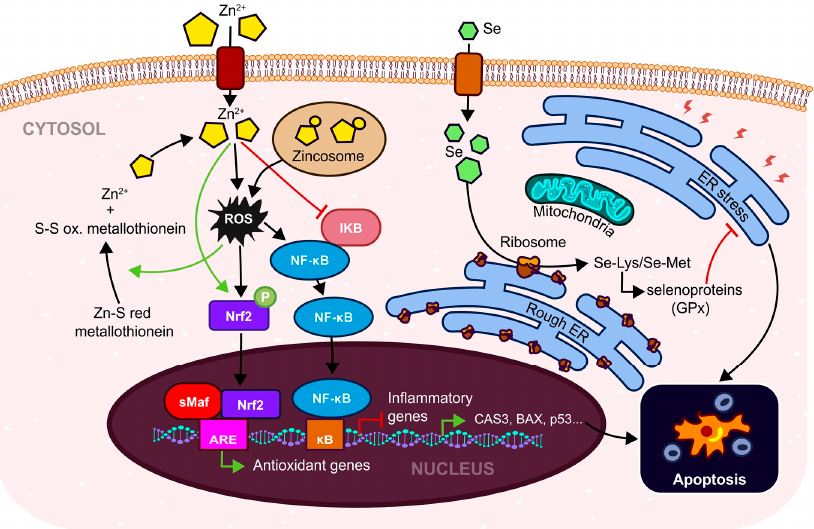
Figure 5. The action mechanism of zinc and selenium in response to oxidative stress. Zinc can be released from metallothionein under protein reduction (formation of disulfidic bond after releasing zinc bound to sulfur in its oxidized form). Free zinc can act directly in reducing OS or can act via activation of Nrf2 signaling (green arrows) and can inhibit (red line) NF- κ B signaling. On the other hand, selenium is incorporated in the amino acids lysine and methionine, and is used in the proteosynthesis of antioxidant enzymes and selenoproteins such as GPx which have the ability to reduce oxidative stress (red line).